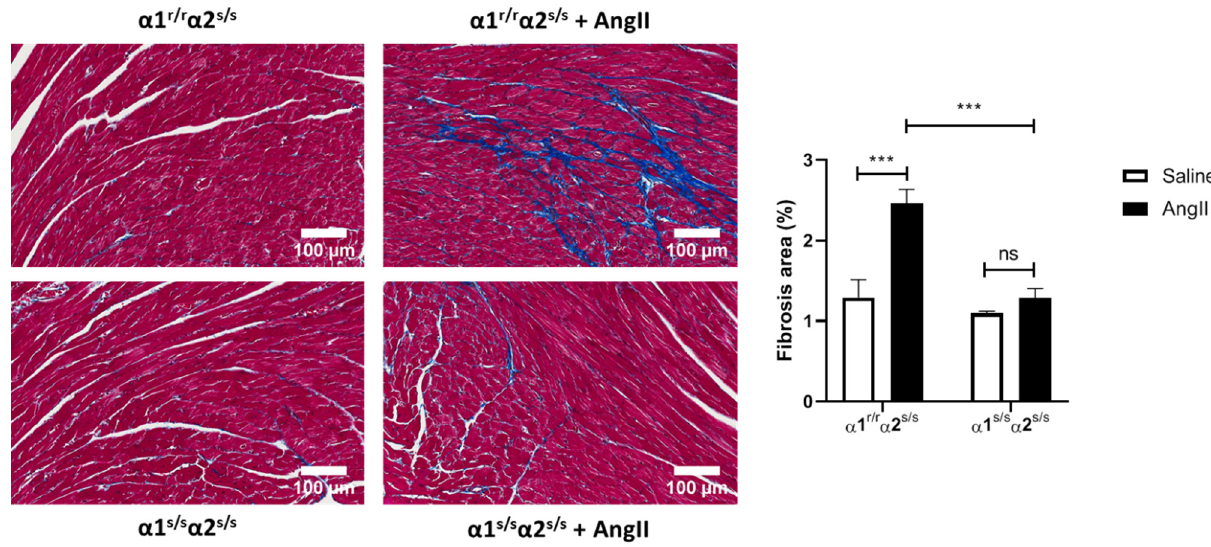
Figure 6. Angiotensin-II does not induce cardiac fibrosis in α 1 s/s α 2 s/s mice: The left panels show representative histological sections stained with Masson’s trichrome, and the right panels show the quantitative data of fibrosis analyzed using ImageJ ( n = 4–8 hearts/group). Scale Bar = 100 µ m. *** p < 0.001; ns: non-significant, p > 0.05.